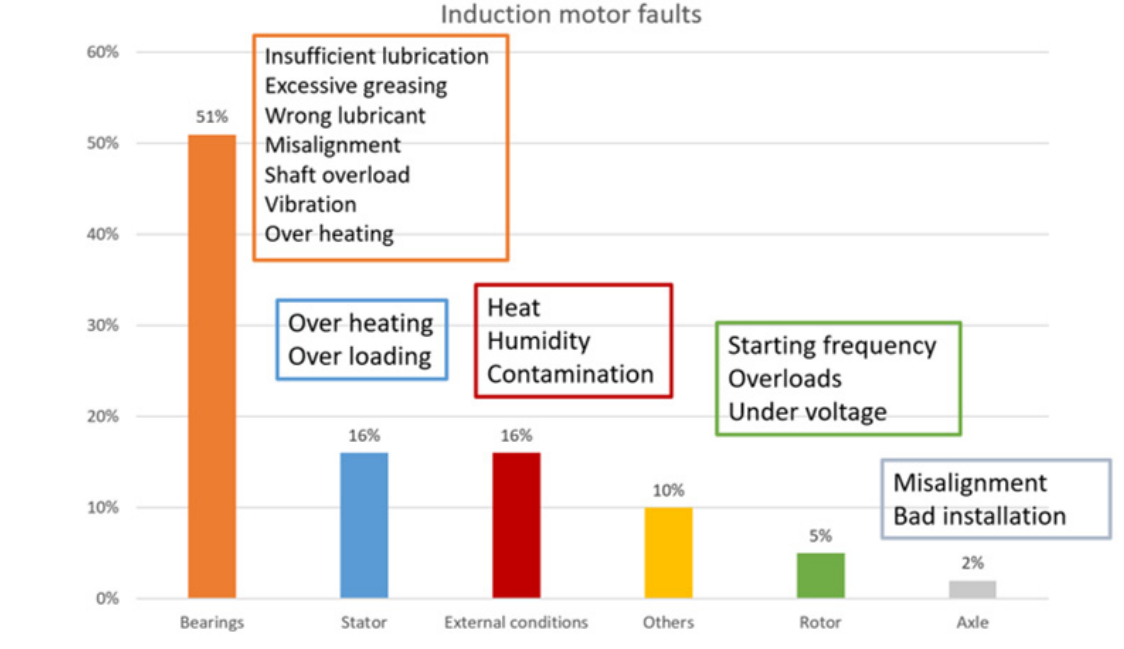
Figure 2. Representation of the critical elements of induction motors and their main causes of failure [3].